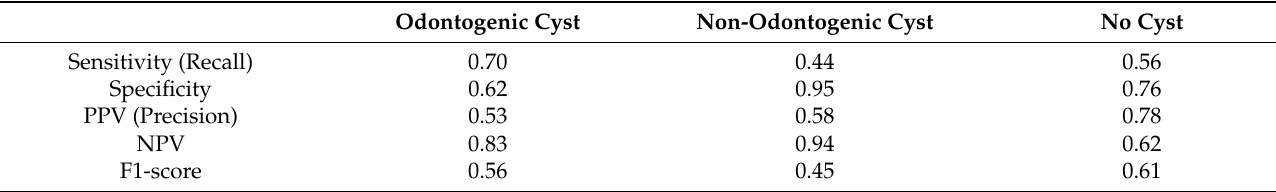
Table 3. Human diagnostic